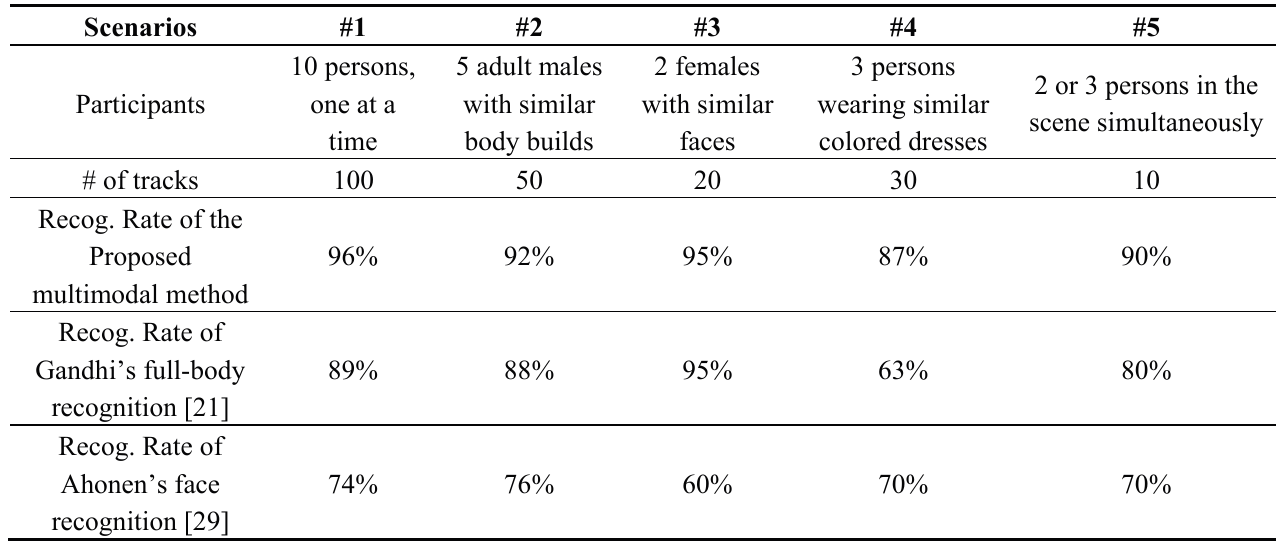
Table 8. Comparison of the recognition rate using different methods in various